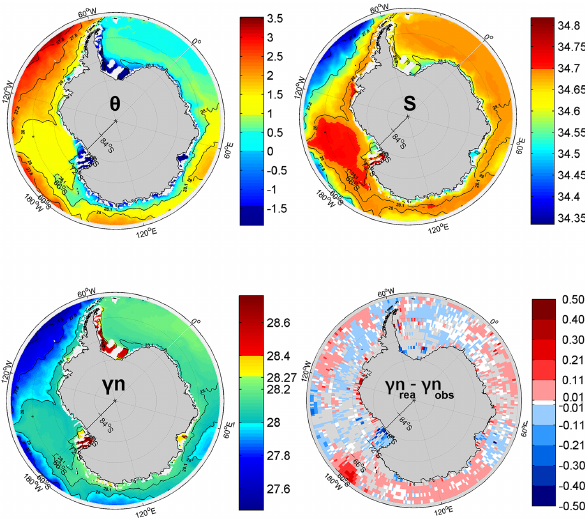
Figure 6. Same as in Fig. 5 except for the IL